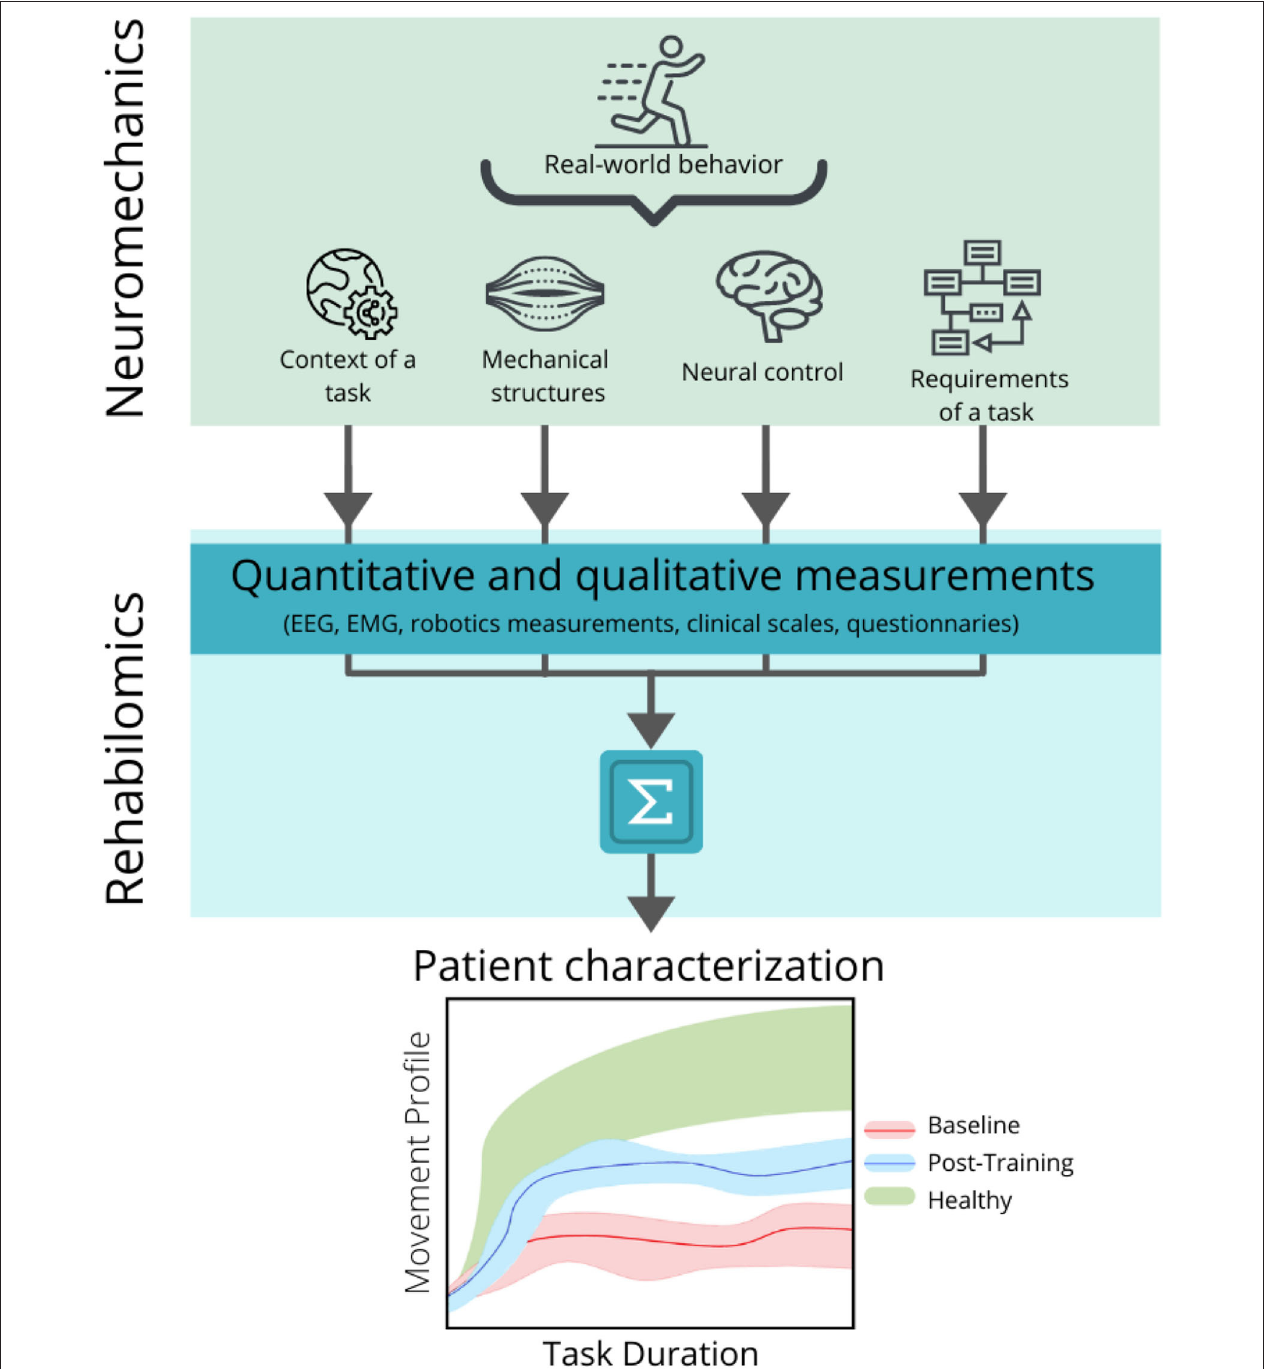
FIGURE 5 | Relationship between the neuromechanical models and the Rehabilomics approach in the development of the motor-related biomarkers. Neuromechanics addresses the real-world behavior by considering the interaction between the context of the motor task, the mechanical structures of the body that are activated to produce the movement, the neural control necessary to produce and modulate the movement, and the specific requirements of the task (top panel). These parameters can be converted into quantitative and qualitative measurements by applying the recording techniques (such as electroencephalography, electromyography (EMG), kinematic measurements, validated clinical scales, and questionnaires) and can be combined to create a personalized profile of the patient (middle panel), in order to assess and predict the motor outcomes related to a specific intervention (bottom panel), before (bottom panel, baseline band in red) and after (bottom panel, post-training band in blue) the rehabilitation, and compare it with a normative band (bottom panel, healthy band in green).